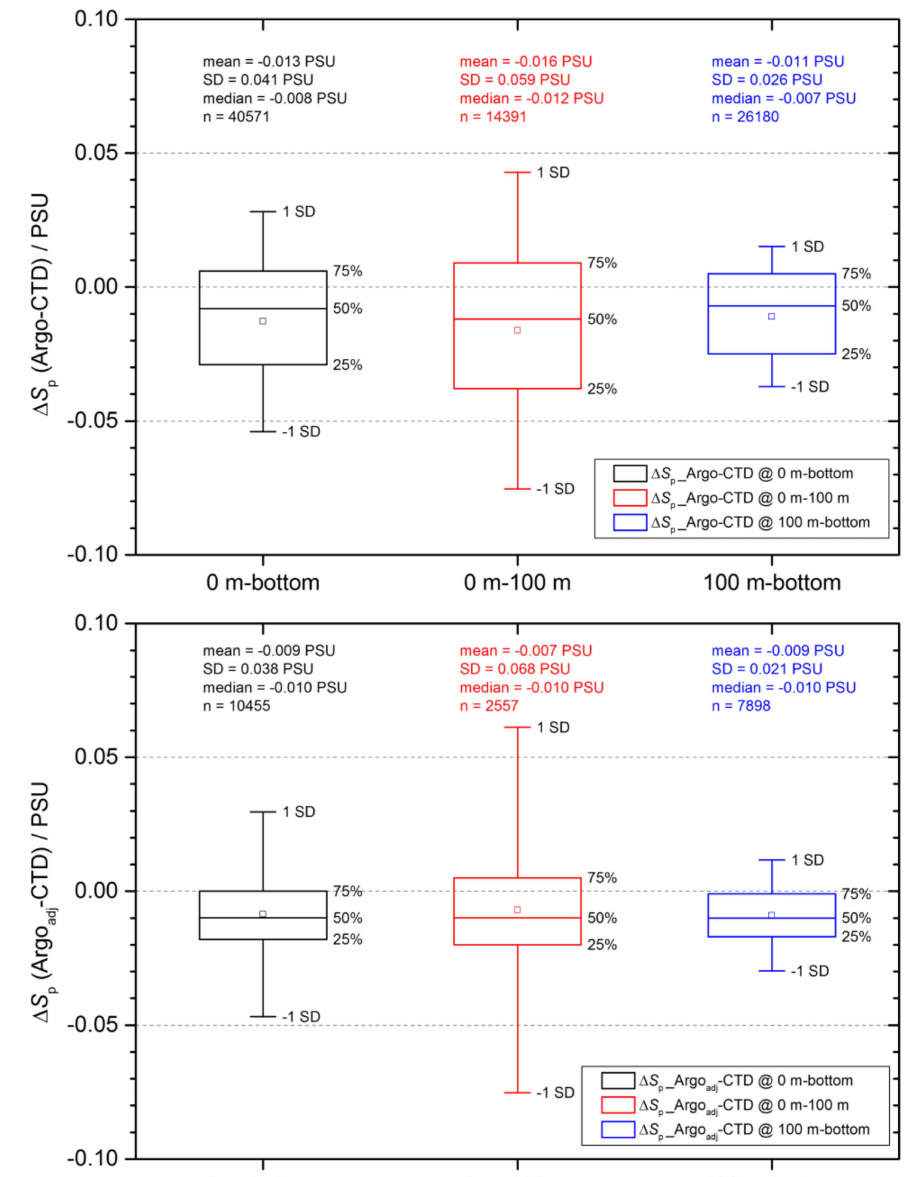
Figure 15. Box plot of salinity di ff erences: Argo (not-adjusted, top , and adjusted, bottom ) vs. CTD. Mean values are indicated by empty